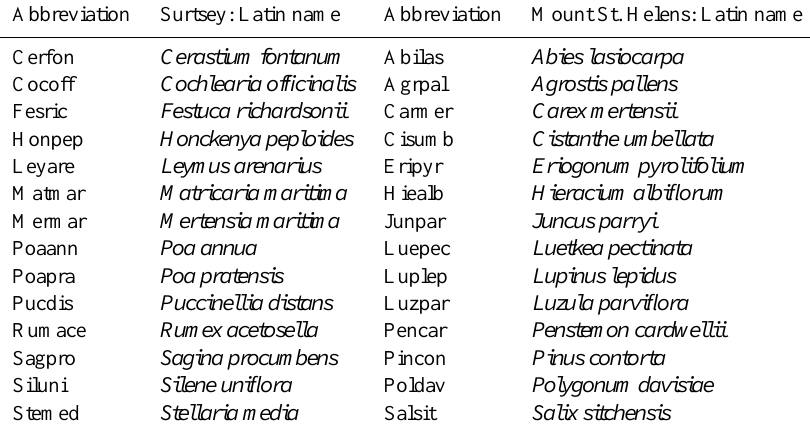
Table A1. Key to abbreviations used in Tables 2 and